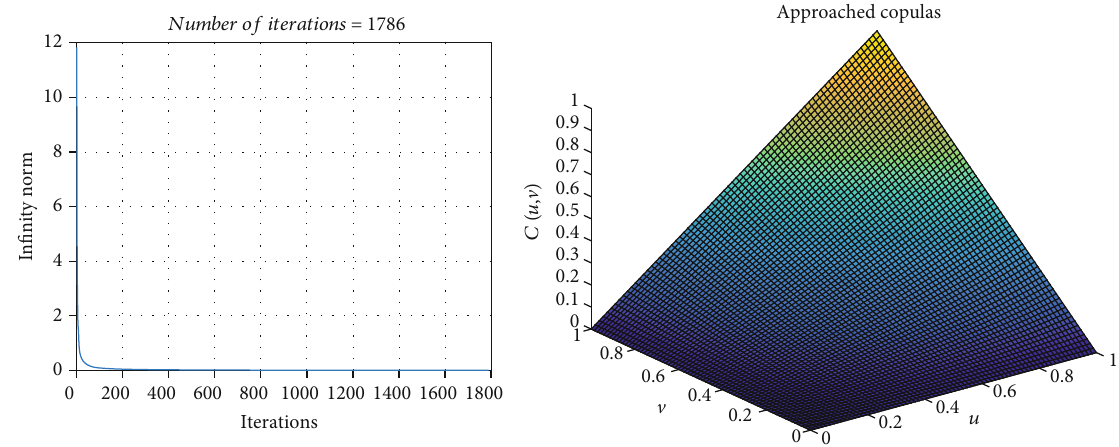
Figure 3: Approached solution of fi nite di ff erence method when N = 70, h = 1/71 , k = 1 , and θ = − 1/2 .